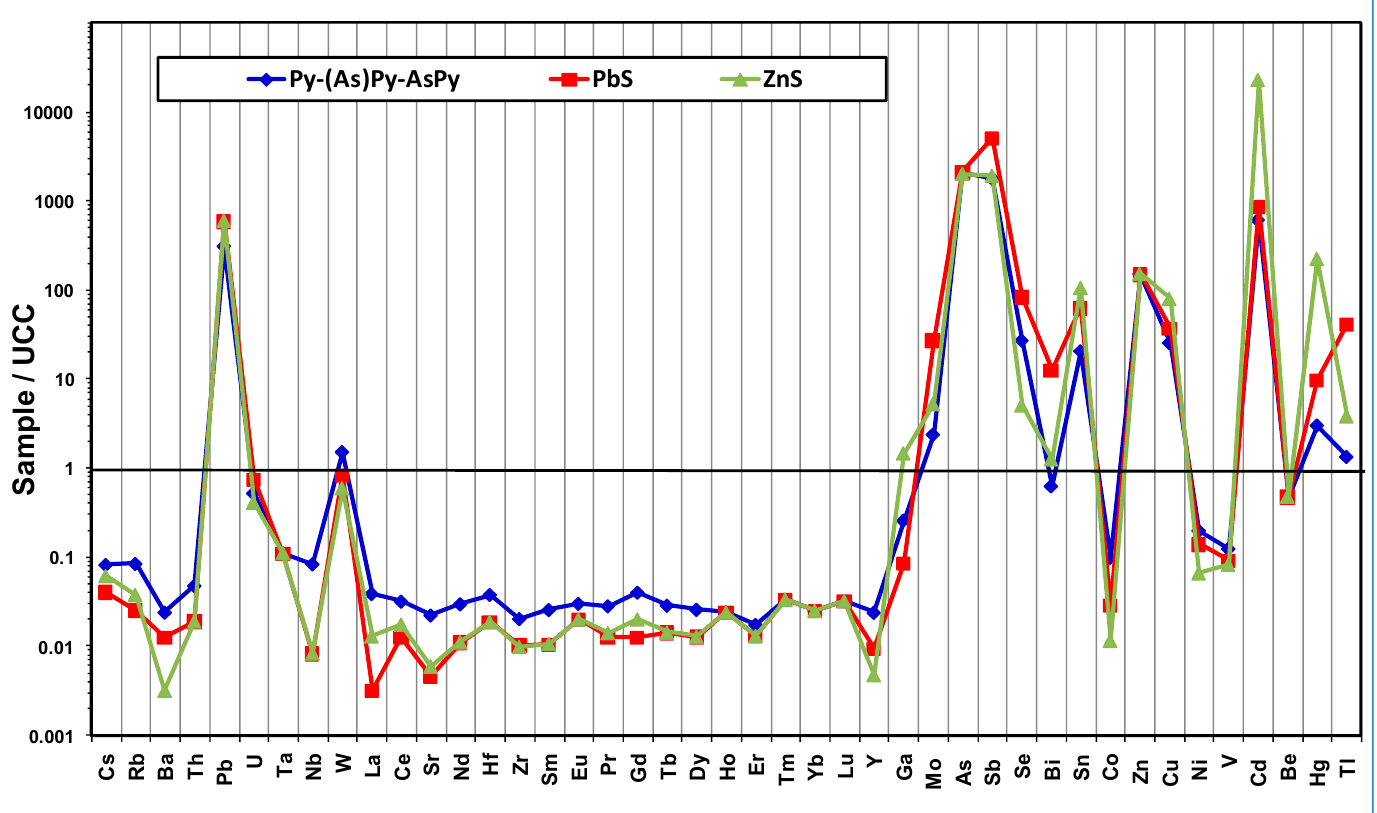
Figure 5. Spider diagram of sample/upper continental crust (UCC).